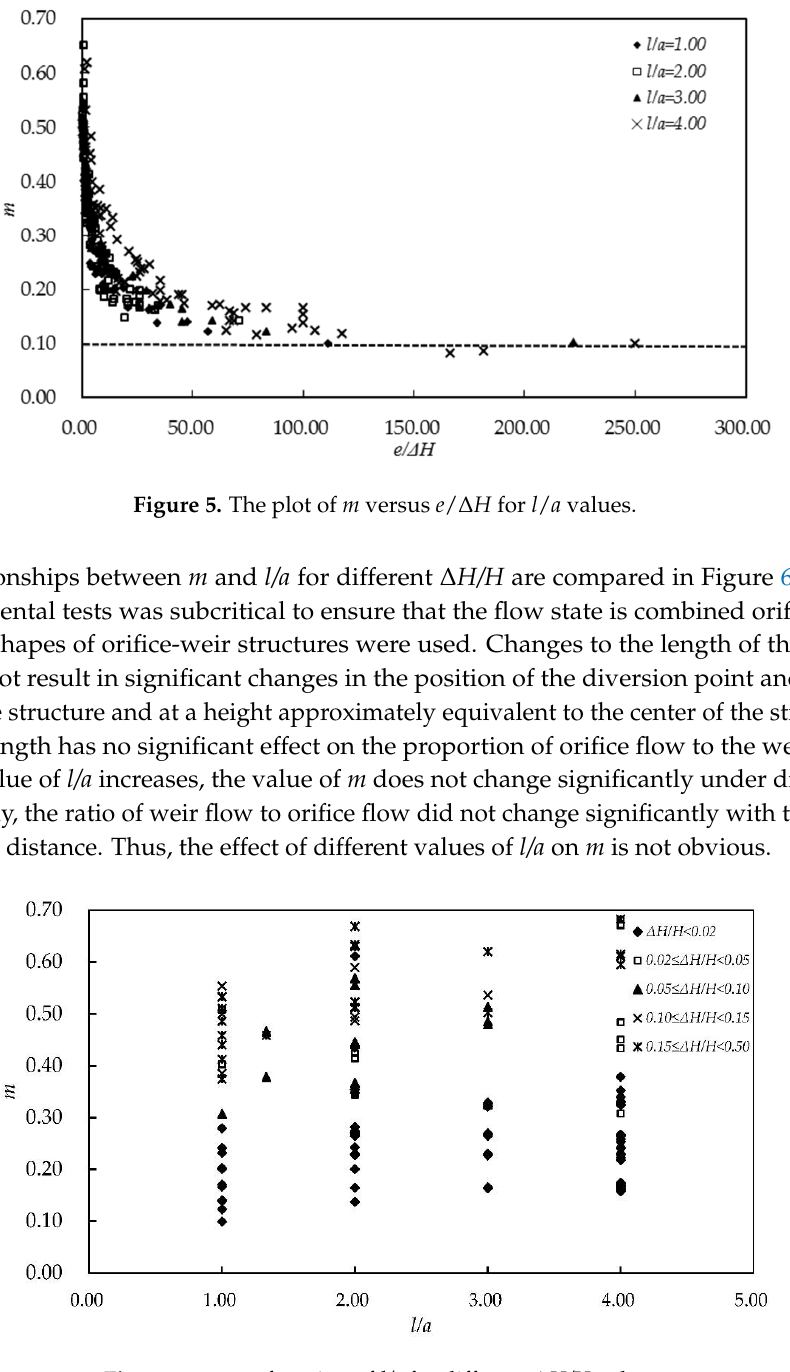
Figure 6. m as a function of l/a for different Δ H/H values.